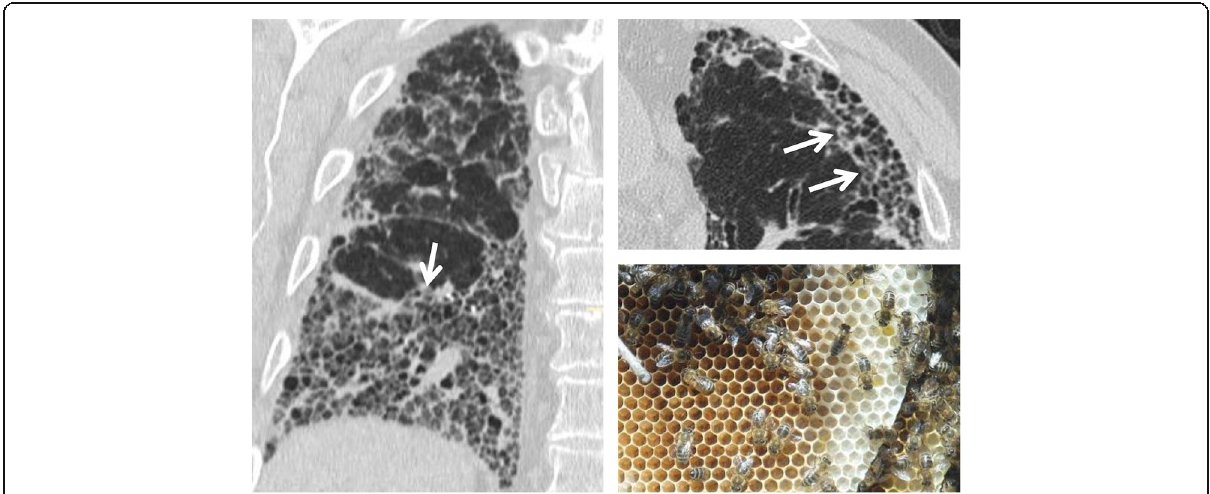
Fig. 20 Honeycombing. The figure shows a patient affected by UIP: this radiological pattern is characterized by traction bronchiectasis, honeycombing, and reticulations — frequently recognizable in basal and subpleural regions. The small cystic areas — seen on coronal scan (left image) and axial scan (right image) is very similar to a honeycomb